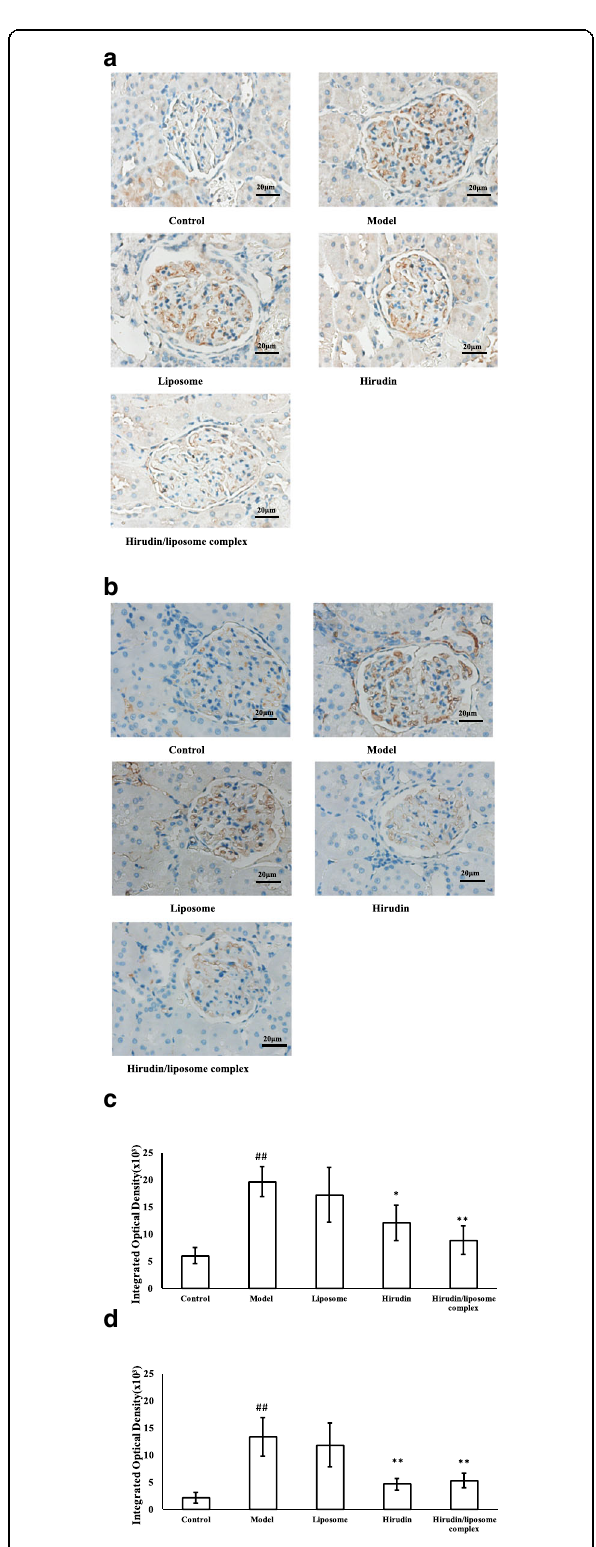
Fig. 10 Immustaining indicated that VEGF levels in the epithelium of the glomerulus ( a , c ) and TGF- β 1 ( b , d ) levels in the stroma of the glomerulus and kidney tubules were decreased in the Hirudin/ liposome complex group compared with the Model group (40x). Control group ( n = 10), Model group ( n = 7), Liposome group ( n = 7), Hirudin group ( n = 8), Hirudin/liposome complex group ( n = 7). ##: P <0.01 compared with Control group; *: P <0.05 compared with Model group;**: P <0.01 compared with Model